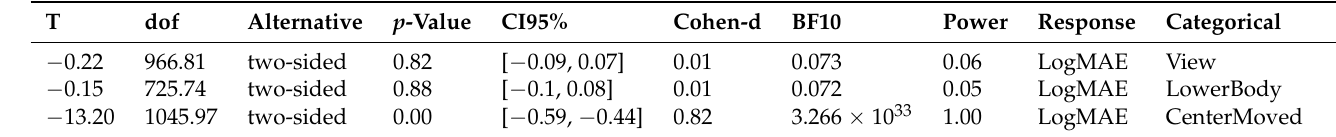
Table 6. The results of the Welch t -test Analysis.